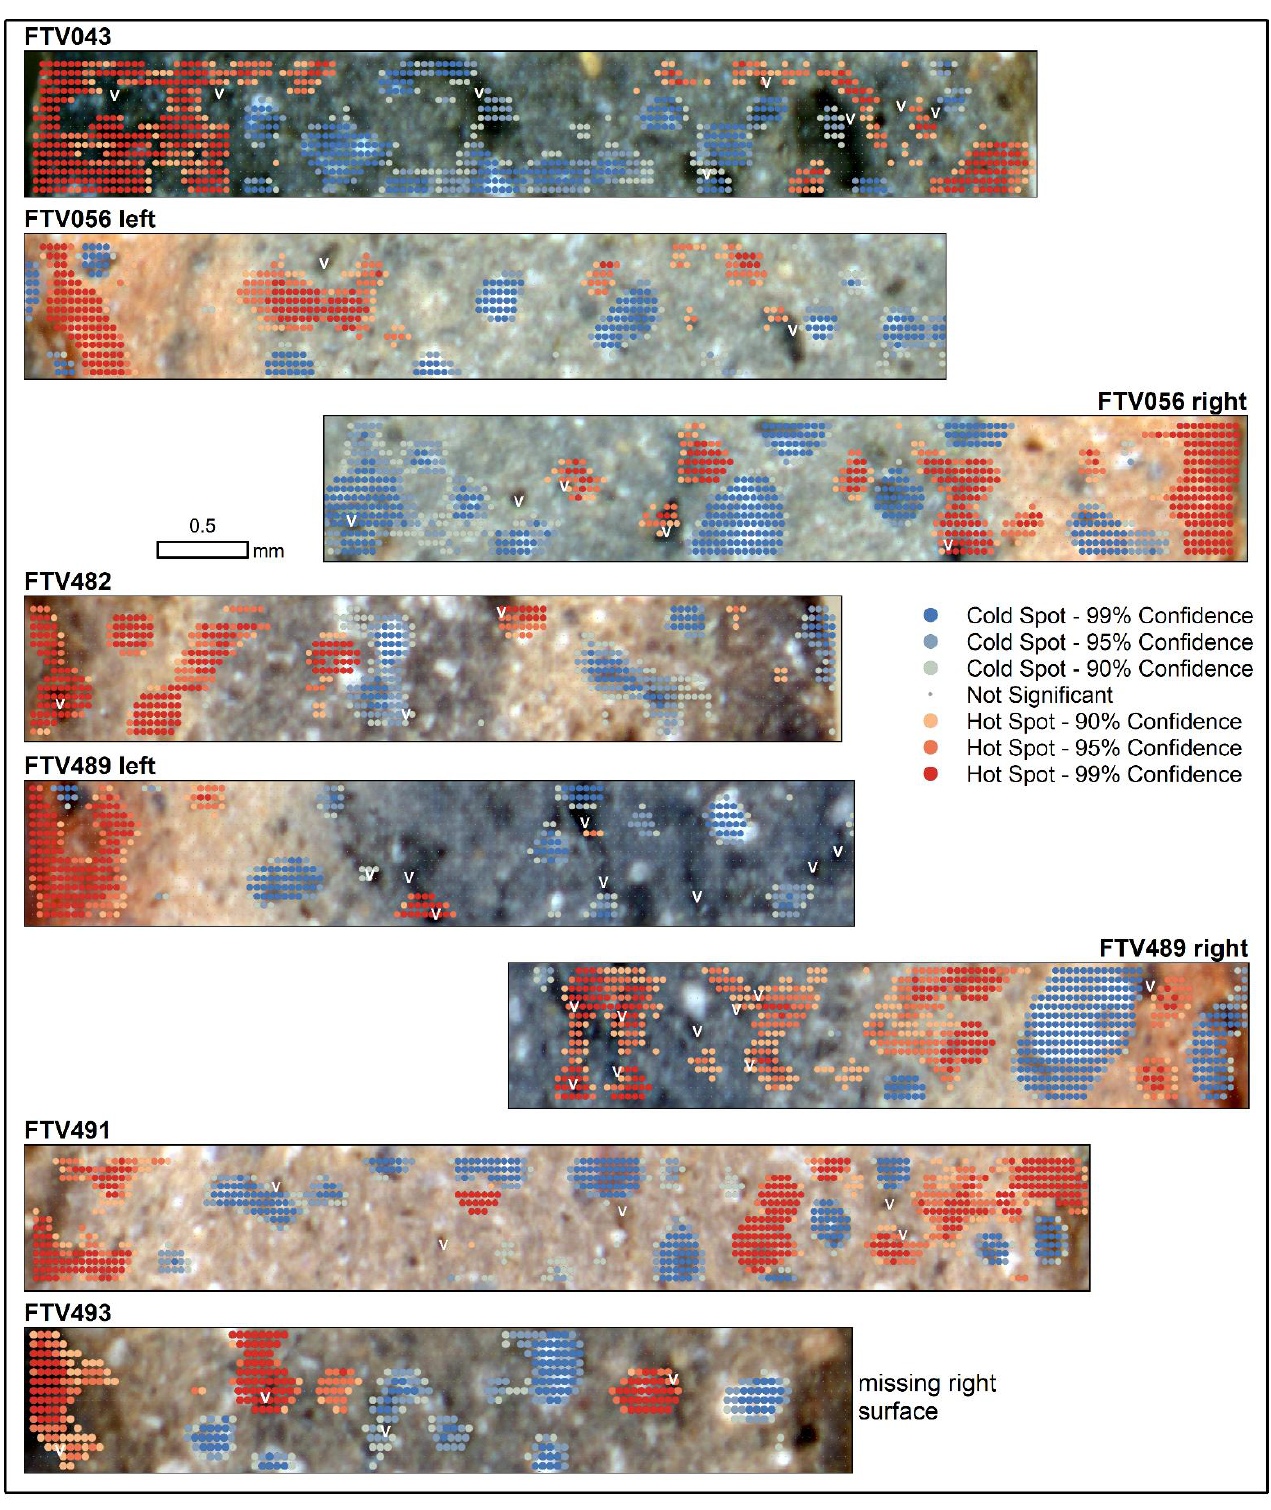
Figure 9. Results of Getis-Ord Gi* showing hot and cool spots across Group A2 ceramics. “V” marks macroscopically visible voids.